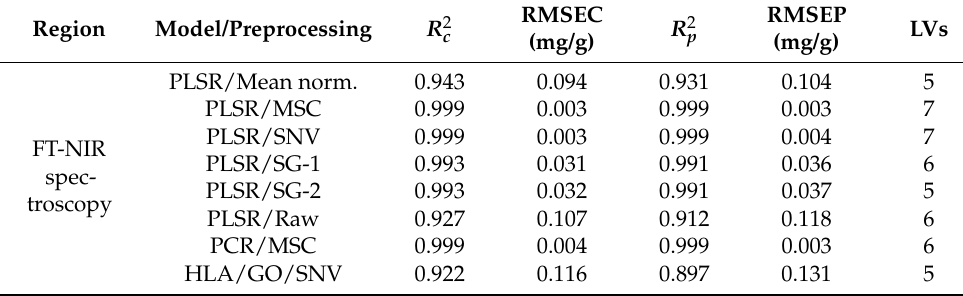
Table 6. Results from the developed PLSR, PCR, and HLA/GO models developed for the prediction analysis of phenolic compounds in A. thaliana leaf powder samples using FT-NIR